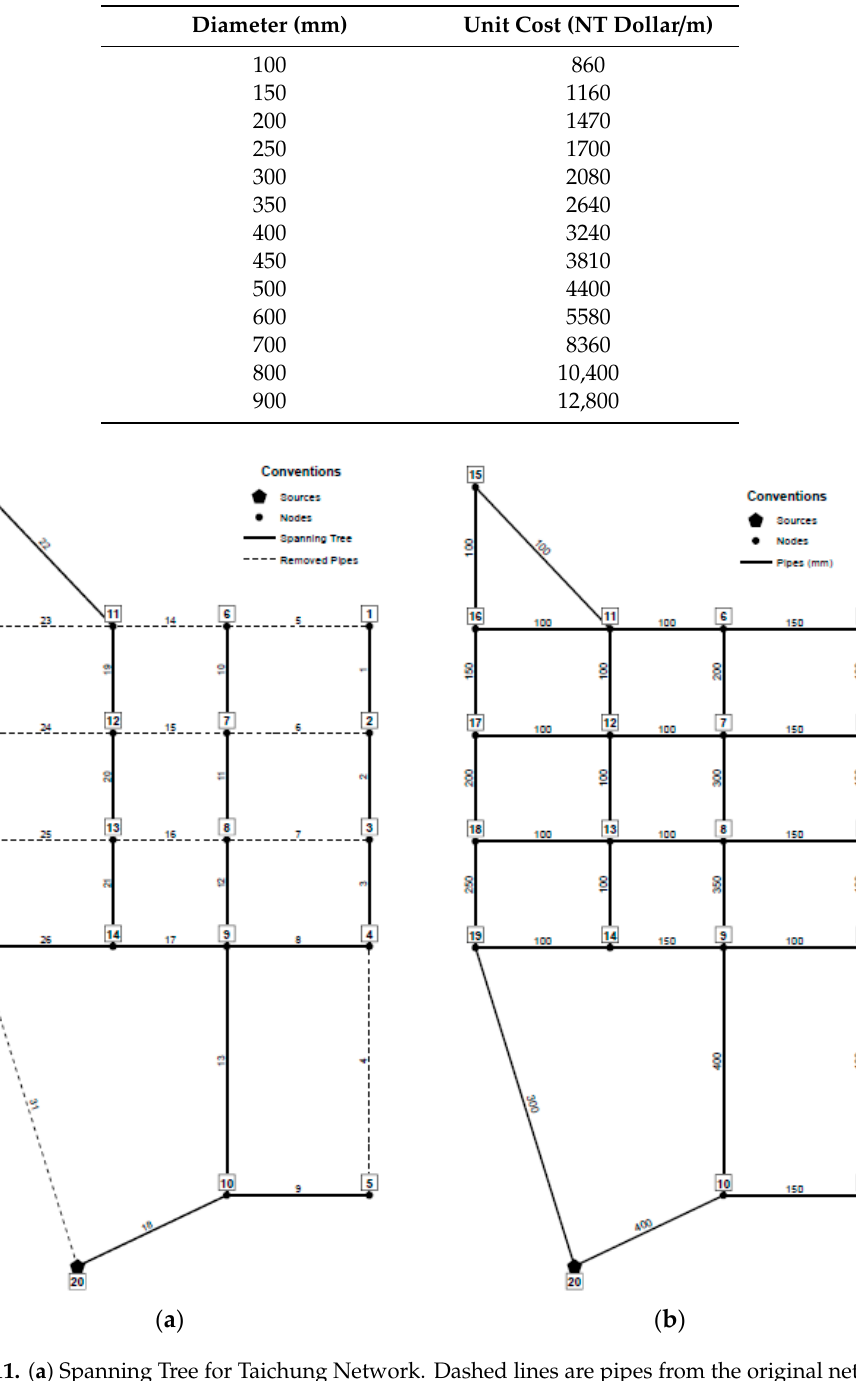
Table 5. Unit costs of Taichung network.